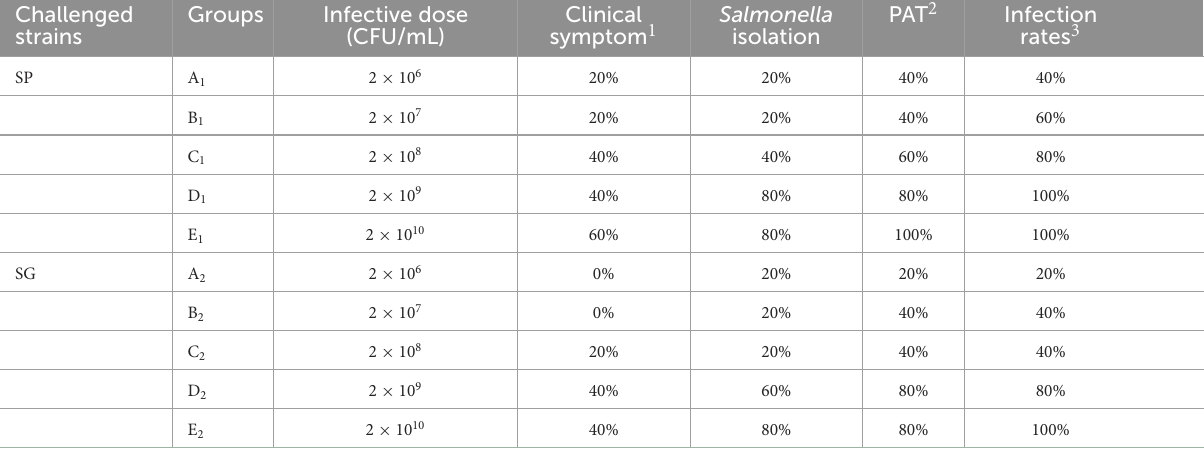
Clinical symptom